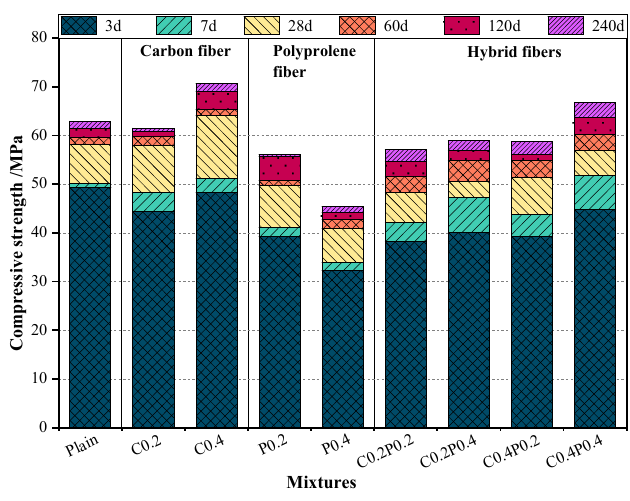
Figure 8. Development of cube compressive strength of LWAC.